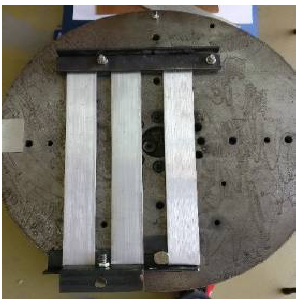
Figure 1. Bar fixing bracket on the robot table.